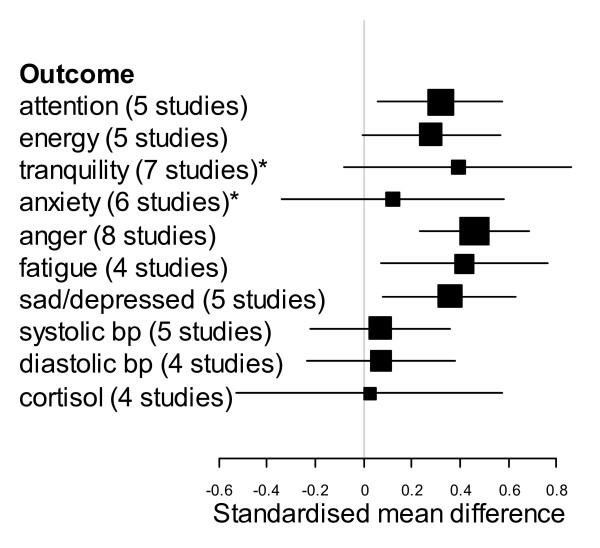
The pooled (weighted average) effect sizes (Hedges g) and 95% CI for each outcome. The sign of the effect size reflects the benefit on health (positive effects indicate greater attention, energy and tranquillity but lower values for the other outcomes). In brackets are shown the number of studies that was used to calculate the effect size and an asterisk is used to denote significant heterogeneity (p < 0.05) within a particular group.